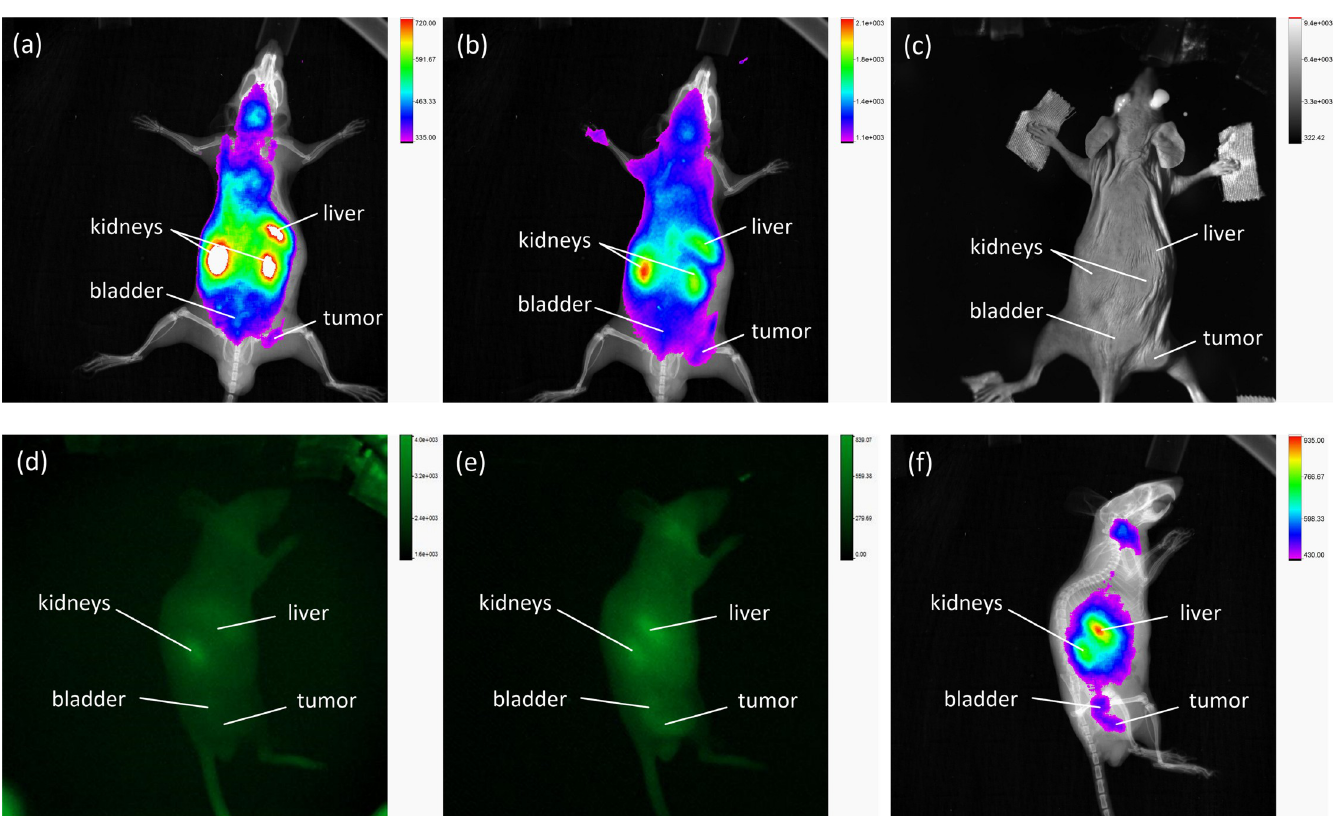
Fig 8. Overlay of X-ray and Fluorescence Imaging at 48 h p.i. Using the In Vivo Xtreme System. (Fig 8A) Fluorescence image of AuNP-SIDAG-LUG obtained at an excitation wavelength of 750 nm to 790 nm and (Fig 8B) 690 nm to 790 nm. (Fig 8C) Corresponding bright field image. (Fig 8D) Fluorescence image obtained at an excitation wavelength of 750 nm to 790 nm from the left side of the mouse. (Fig 8E) Fluorescence image obtained at an excitation wavelength of 690 nm to 790 nm from the left side of the mouse. (Fig 8F) Fluorescence image overlay of AuNP-SIDAG-LUG obtained at an excitation wavelength of 690 nm to 790 nm from the left side of the